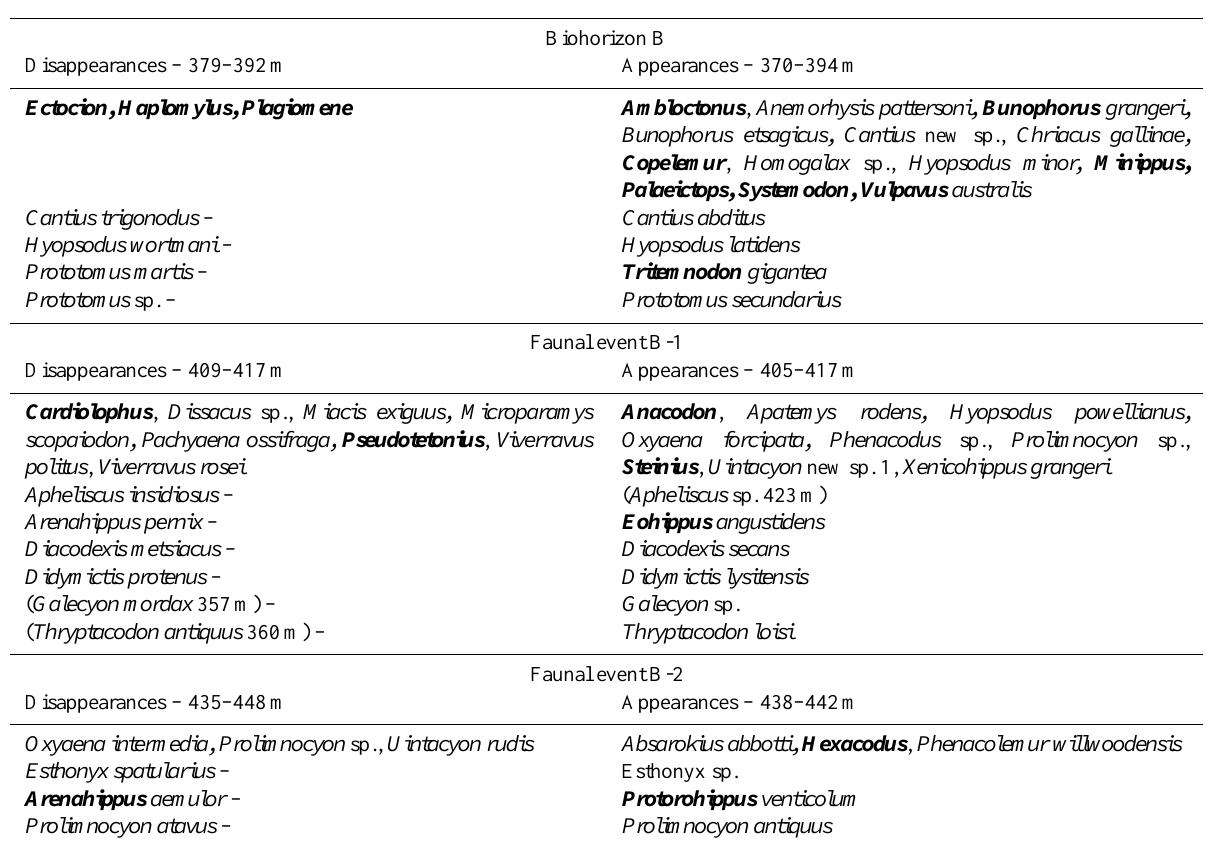
Table 1. First and last appearances of species at Biohorizon B and faunal events B-1 and B-2. Paired species represent segments of what are thought to be individual lineages. Taxa in parentheses did not have first or last appearances within the significant intervals but are probably related to the event. Bold-faced taxa indicate the appearance or disappearance of a